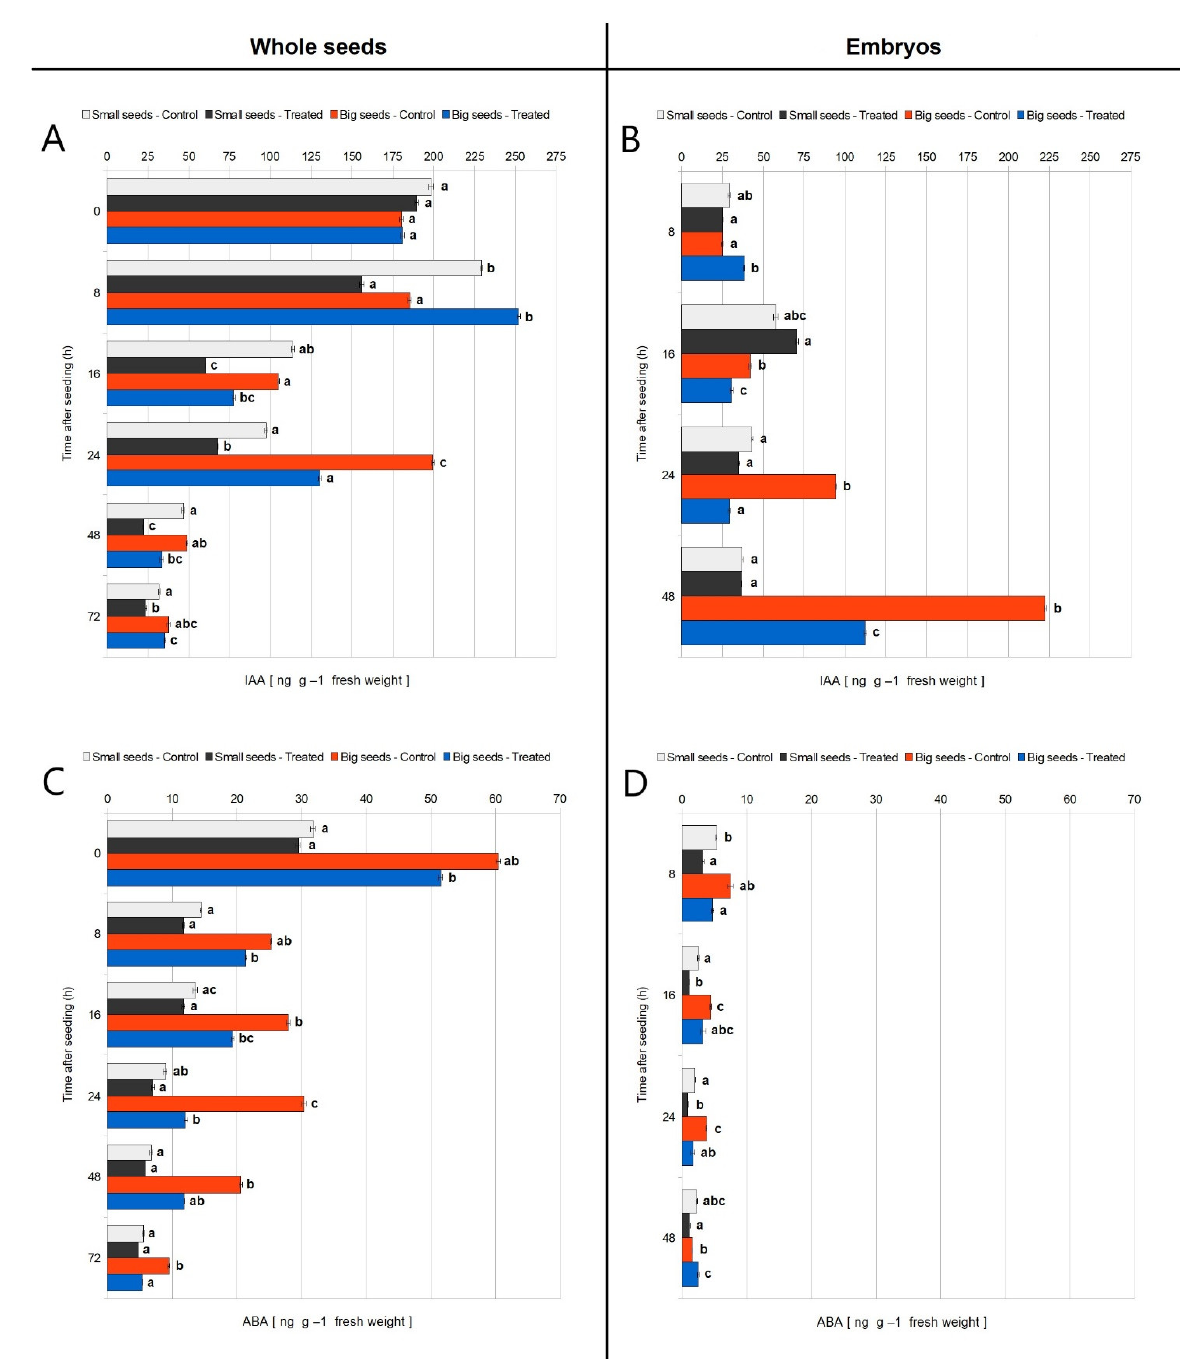
Figure 5. The amount of IAA and ABA phytohormones in control and EMF-treated samples of whole seeds ( A , C ) and isolated embryos ( B , D ) of small and big-sized winter wheat seeds germinating in darkness. Data are shown as mean values ( n = 3), and bars represent standard error ± SE. Different letters above the bars indicate significant differences at p < 0.05 (two-tailed t -test). After the EMF treatment, the small and big seeds reacted differently, with changes in IAA levels in the whole seeds and the isolated embryos. In the whole small seeds, EMF exposure caused a significant decrease in the IAA concentration compared to their con- trols during the germination period of 8–72 h AS (Figure 5A). The biggest declines of 32% and 47% were observed at 8 h and 16 h AS, respectively. The IAA response to EMFs in the